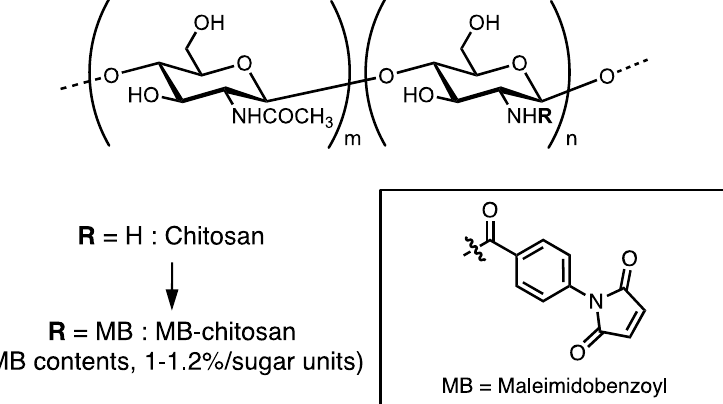
Figure 1. Preparation of maleimidobenzoyl (MB)–chitosan. Chitosan was reacted with MBS ( N -( m -maleimidobenzoyloxy) succinimide) in dimethylformamide (DMF) solution. Substitution ratio of the MB groups to the chitosan was approximately 1–1.2%/sugar unit.